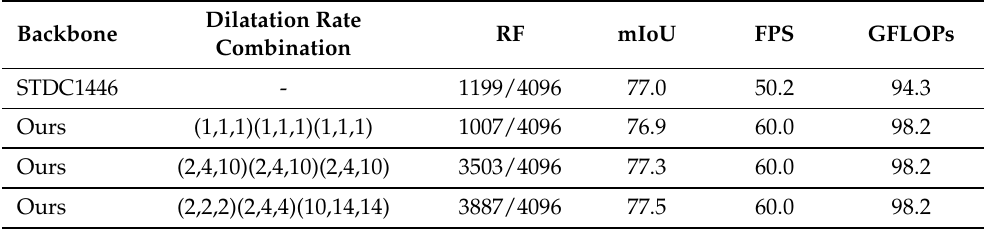
Table 2. Comparison of the effects of different maximum receptive fields size; RF denotes recep- tive field.